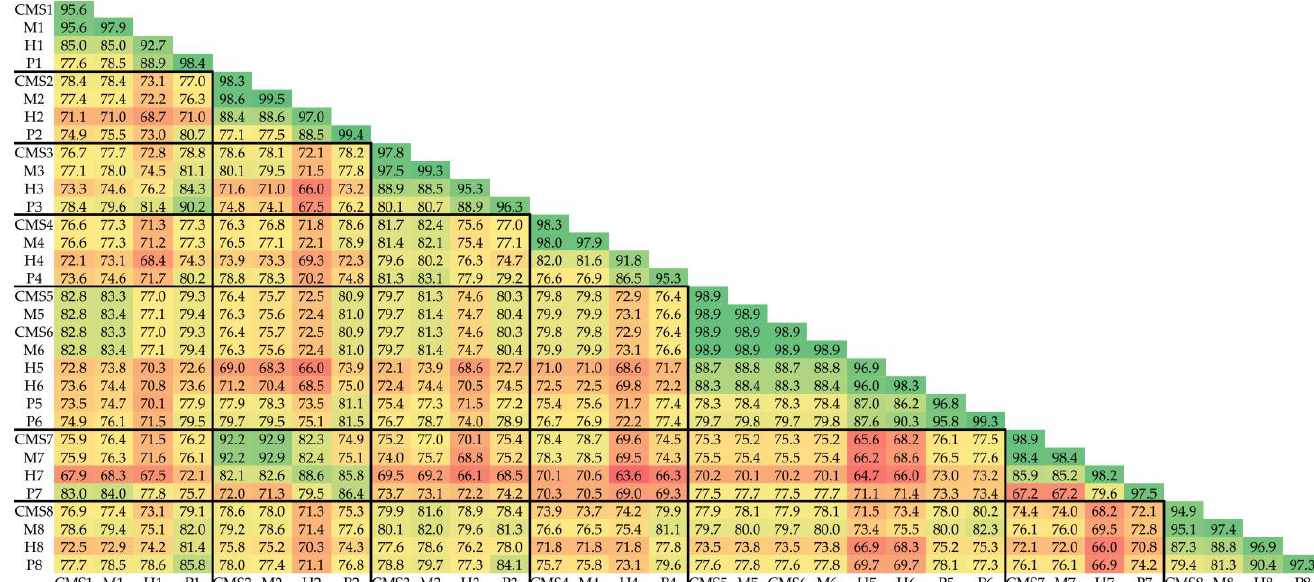
Figure 2. Average genetic similarity percentages (GS%) calculated within and among each population using Rohlf’s simple matching coefficient. Variance values for each pairwise comparison between lines and within lines were also computed, resulting in <0.5%.